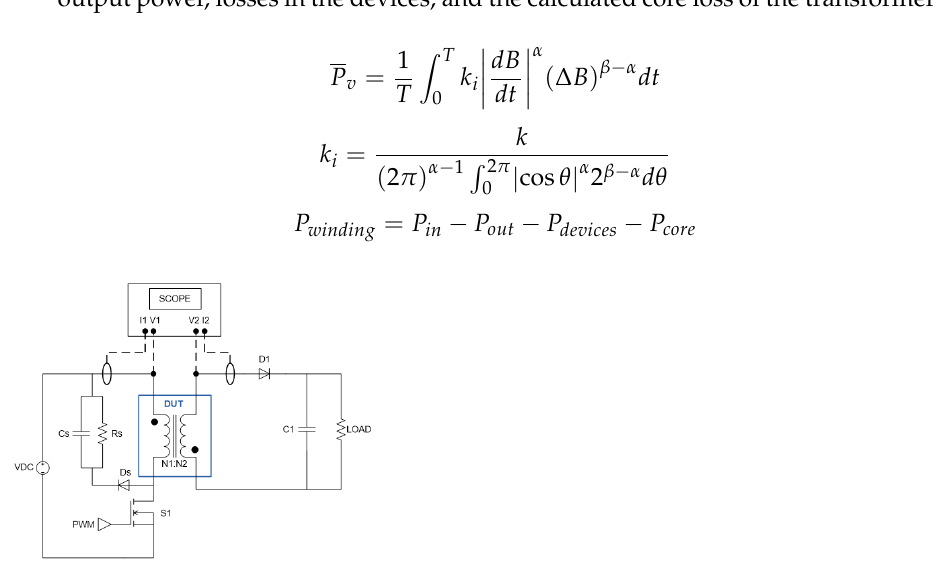
Figure 13. Measurement setup scheme used for measuring winding loss in a flyback converter’s gapped transformer.